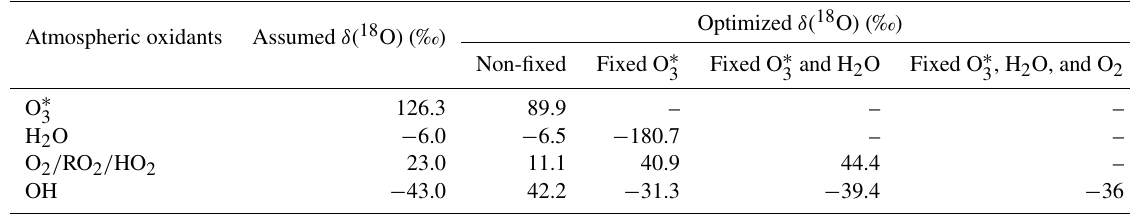
Table 3. δ ( 18 O) values for each oxidant before and after optimization based on different scenarios.